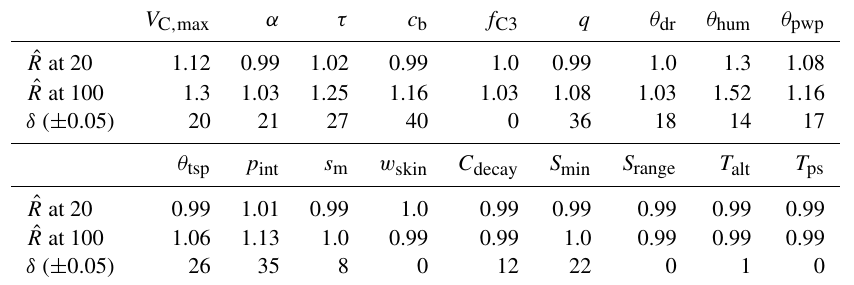
Table 4. Parameter scale reduction ˆ R (at APIS iteration) and stability δ (threshold number of iterations) estimates from the Bethy simulations.